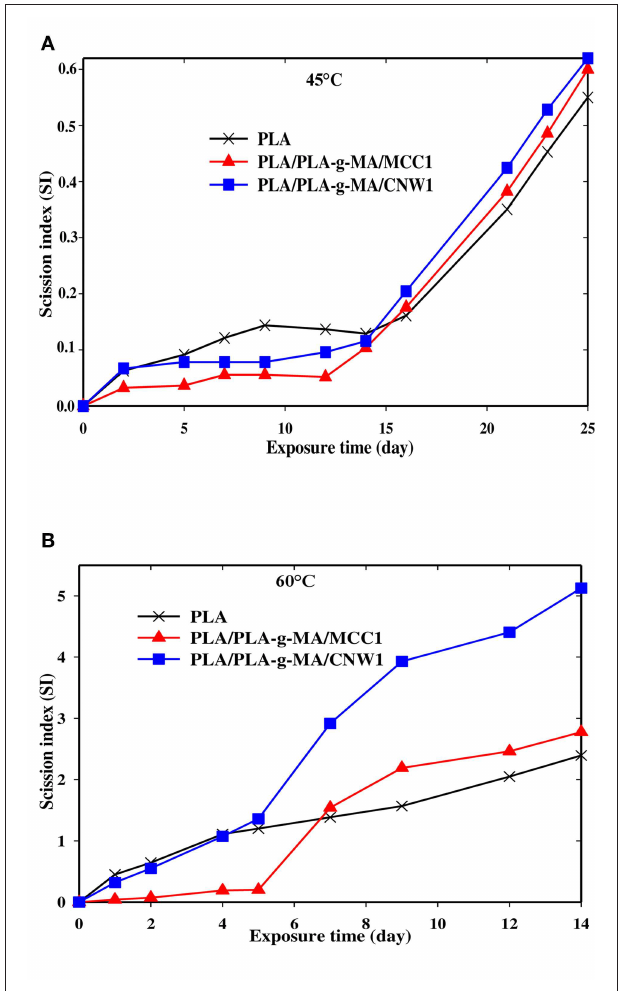
FIGURE 2 | Scission index (SI) vs. exposure time for PLA, PLA -g- MA/MCC1 and PLA -g- MA/CNW1 fibers recorded at 45 ◦ C (A) and 60 ◦ C (B) in hygrothermal